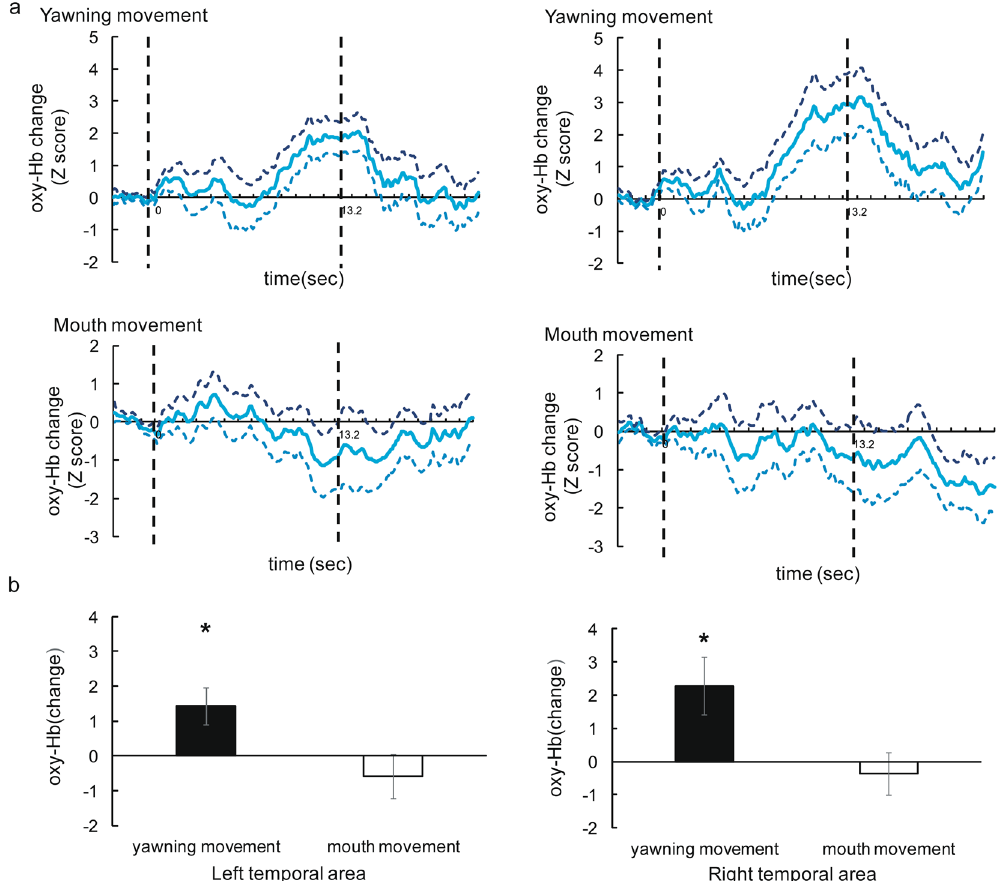
Figure 2. Results of the NIRS measurement in infants. ( a ) The time course of the average change in oxyhemoglobin (oxy-Hb) in 5- and 8- month- olds during the yawning movement and mouth movement conditions. The left column shows the hemodynamic changes in left temporal area, and the right column shows the hemodynamic changes in right temporal area. The thick line in graph represents the mean Z score, and broken line represent the range of ± 1 standard of error of mean (SEM). On the horizontal axis, 0 represents the beginning of the presentation of both movements and 13.2 represents the end of the presentation of both movements; the vertical dashed line at 0 and 13.2 s denote the onset and offset of the test stimulus presentation, respectively. ( b ) Mean Z scores during the 8–14 s presentation in the left and right temporal areas. The error bars represent ± 1 SEM. In yawning movement condition, the concentrations of oxy-Hb in both temporal areas were significantly greater than the chance level of 0. * p < 0.05.